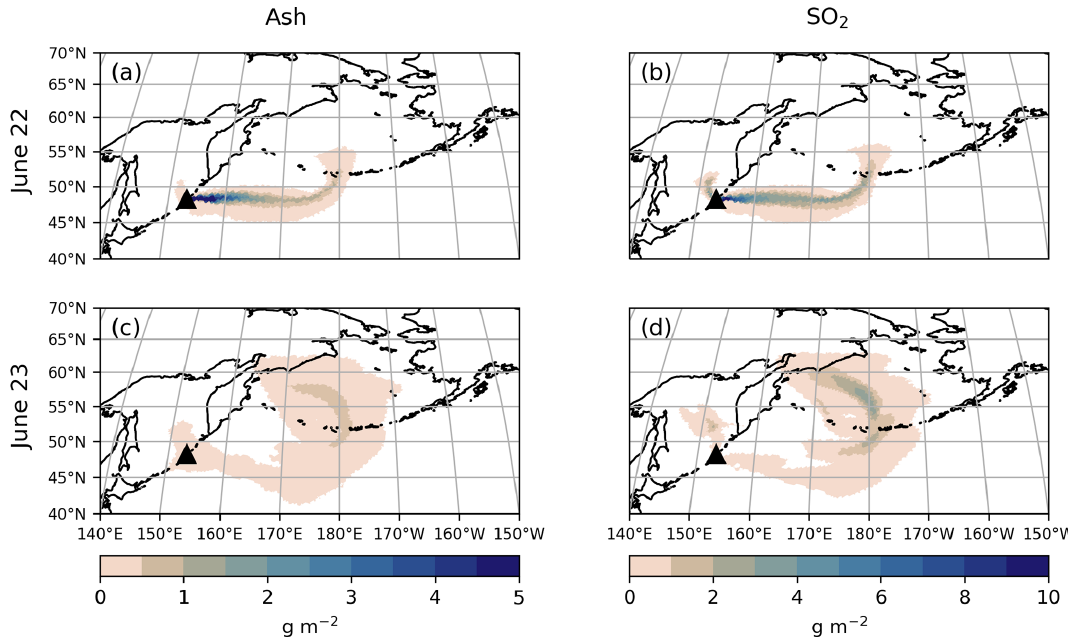
Figure 3. Simulated daily mean column mass loadings for ash (a, c) and SO 2 (b, d) on 22 June 2019 at 00:00–23:00UTC (a, b) and 23 June 2019 at 00:00–23:00UTC (c, d) (gm − 2 ). The results are based on the FPlume-rad